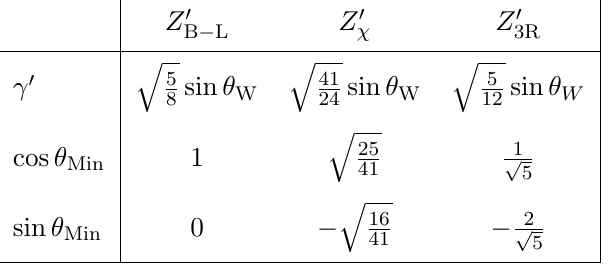
Table 1 . Values for (cid:13) 0 and (cid:18) Min in the Minimal Z 0 models corresponding to three speci(cid:12)c Z 0 bosons: Z 0 , Z 0 and Z 0 . The SM weak mixing angle is denoted by (cid:18) W (cid:31) B (cid:0) L 3R